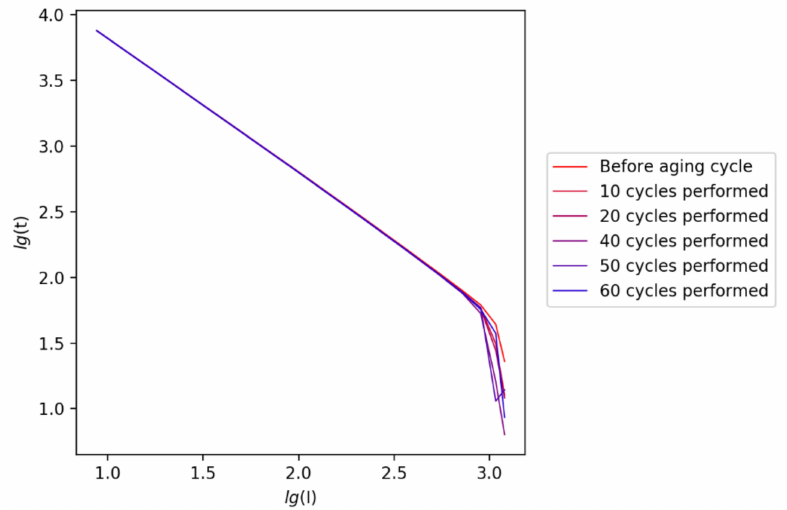
Figure 7. The Peukert constant of cell #2 during aging cycles.